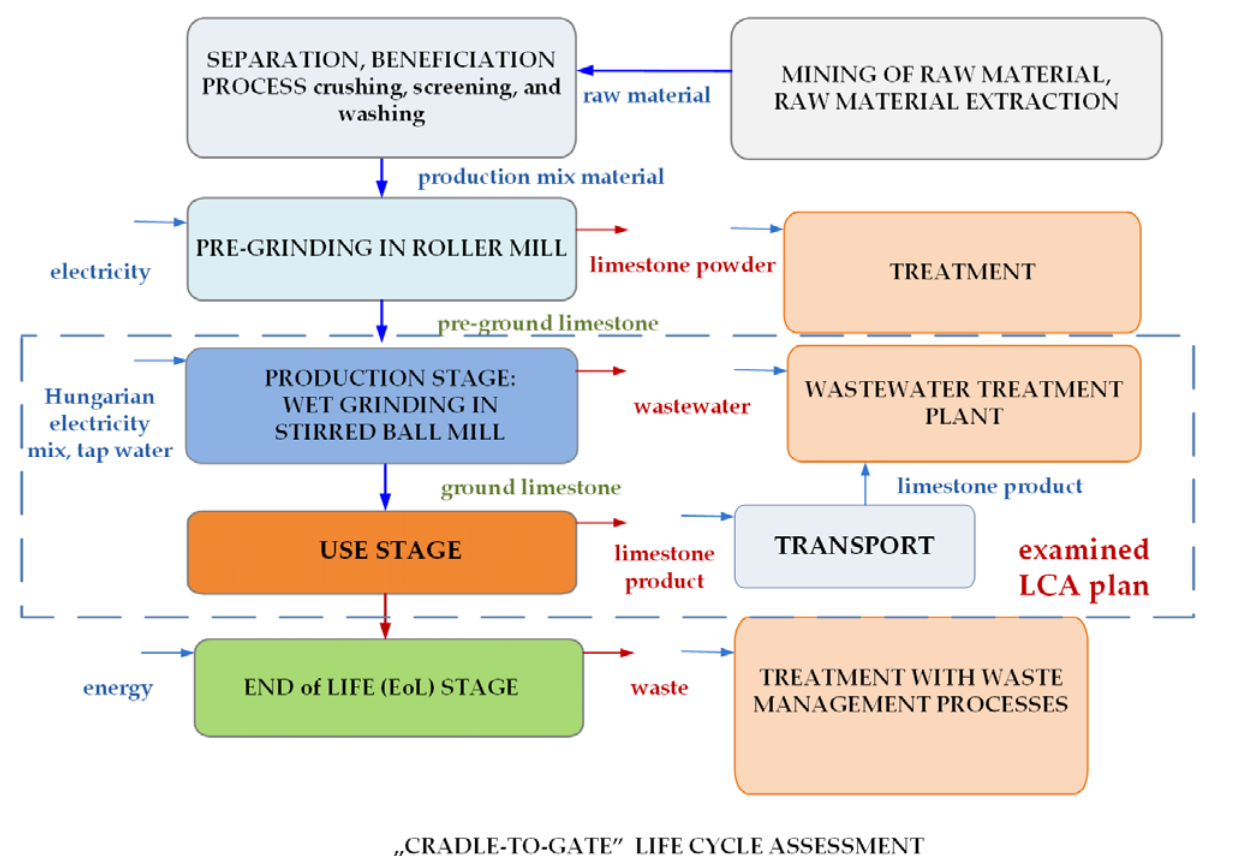
Figure 4. Life cycle ‐ model for wet grinding.